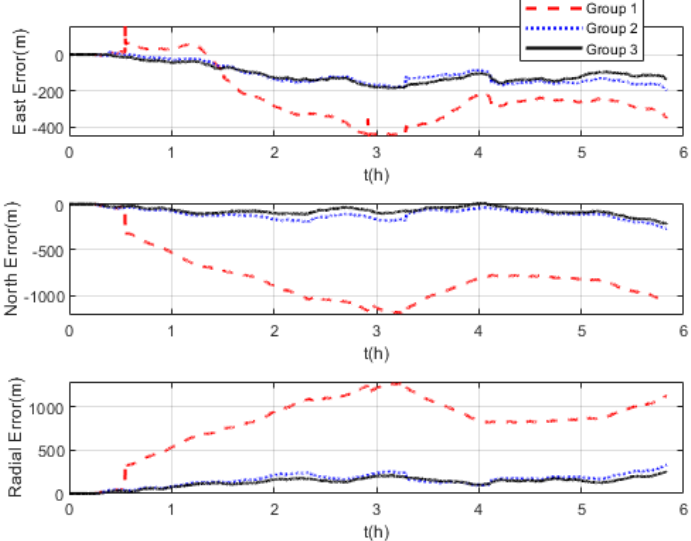
Figure 15. Positioning errors at high latitudes.